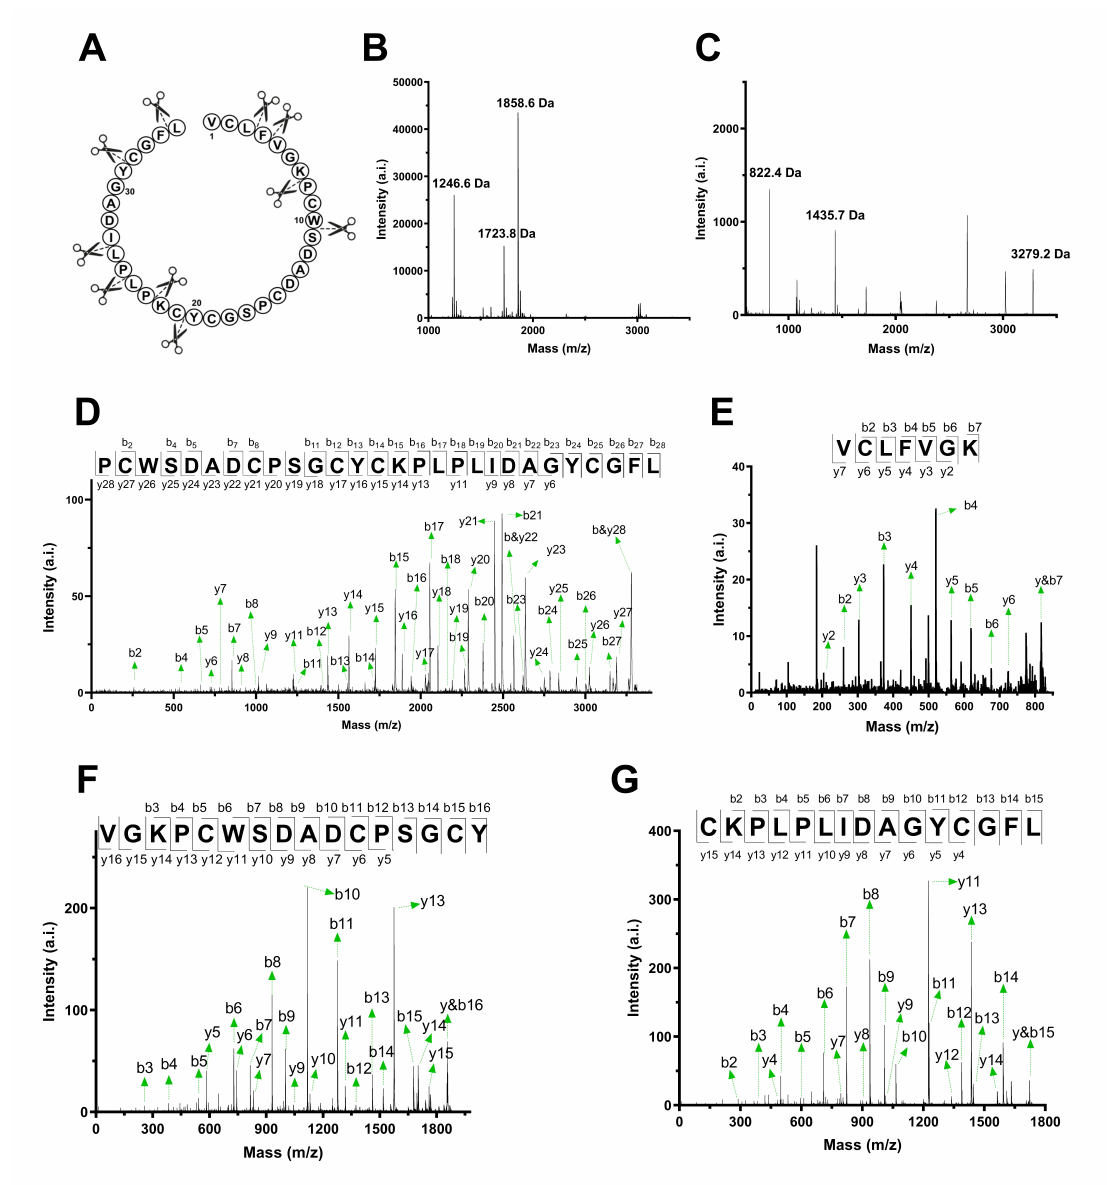
Figure 3. De novo sequencing of citcol-2 by MALDI-TOF / TOF. ( A ) Schematic structure and full sequence of citcol-2; scissors on the inside of the circle indicates potential trypsin cleavage sites and scissors on the outside indicate potential chymotrypsin cleavage sites. MS spectrum of citcol-2 after partial digestion with chymotrypsin ( B ) and trypsin ( C ). MS / MS fragmentation spectra of precursor peptides with a molecular weight of 3279.2 Da ( D ) and 822.4 Da ( E ) after tryptic digestion, and 1858.6 Da ( F ) and 1723.8 Da ( G ) after chymotrypsin digestion, which covers the entire sequence of citcol-2. The amino acid sequence was determined by assembly of digested fragments and assignment of N-terminal b- and C-terminal y-ions series. Complete tryptic digestion was used to distinguish between isobaric amino acids Gln / Lys and complete chymotrypsin for Leu / Ile. Comparison of the sequences of the fragments produced by these two enzymes showed the correct order of the fragments. The m / z value list of each of the precursor masses used for de novo sequencing are shown in Figure S1, where A, B, C and D correspond to precursors with a molecular weight of 3279.2 Da, 822.4 Da, 1723.8 Da and 1858.6 Da,